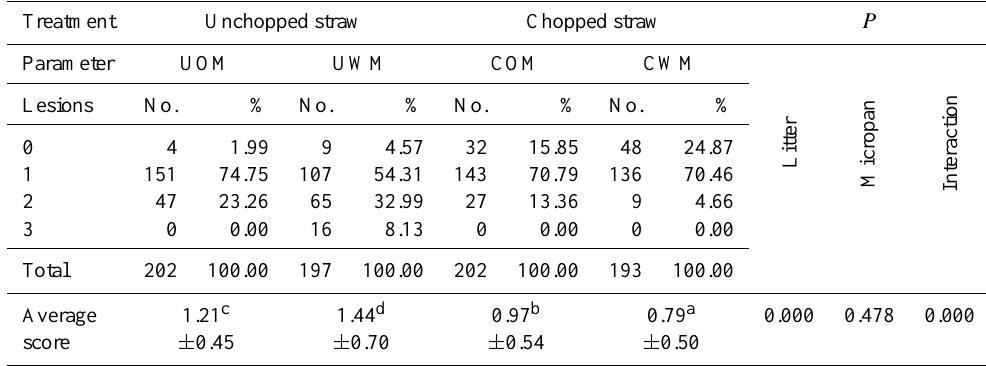
Table 3. Effect of straw size and litter amendment (Micropan) on the incidence of foot pad dermatitis (FPD) in broilers at 3 weeks of age ( ¯ x ± SD). Treatment